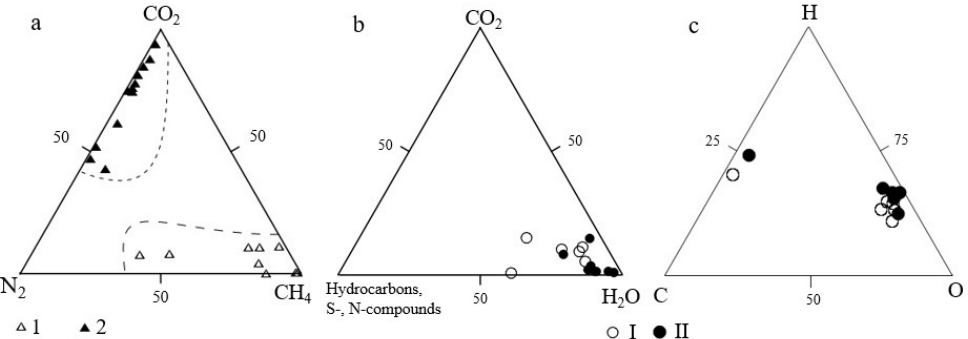
Figure 4. Vapor phase composition of fluid inclusions in minerals of quartz veins from the Blagodatnoye gold deposit (explanations are given in the text): ( a ) from Raman spectroscopy data. Types of fluid inclusions in quartz: 1—type B, L H2O + L(V) CO2 ± CH4 ± N2 ; 2—type C, L(V) CO2 ± CH4 ± N2 . ( b , c ) from gas chromatography-mass spectrometry data. Mineral associations: I—gold-bearing,